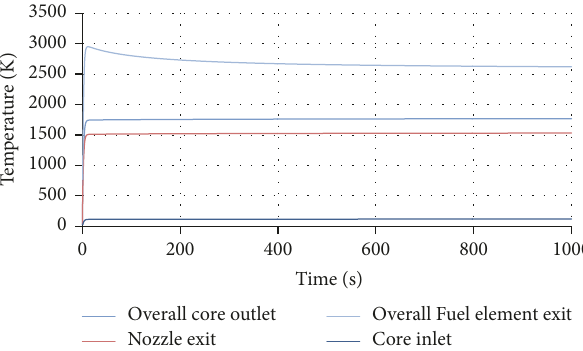
Figure 10: Temperatures in the Pewee steady-state